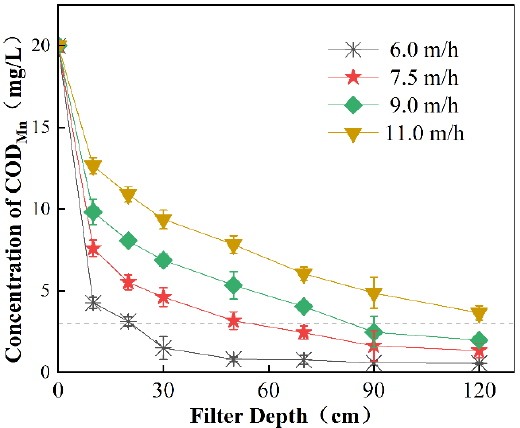
Figure 4. The effect of the filtration rate on the removal of COD Mn.